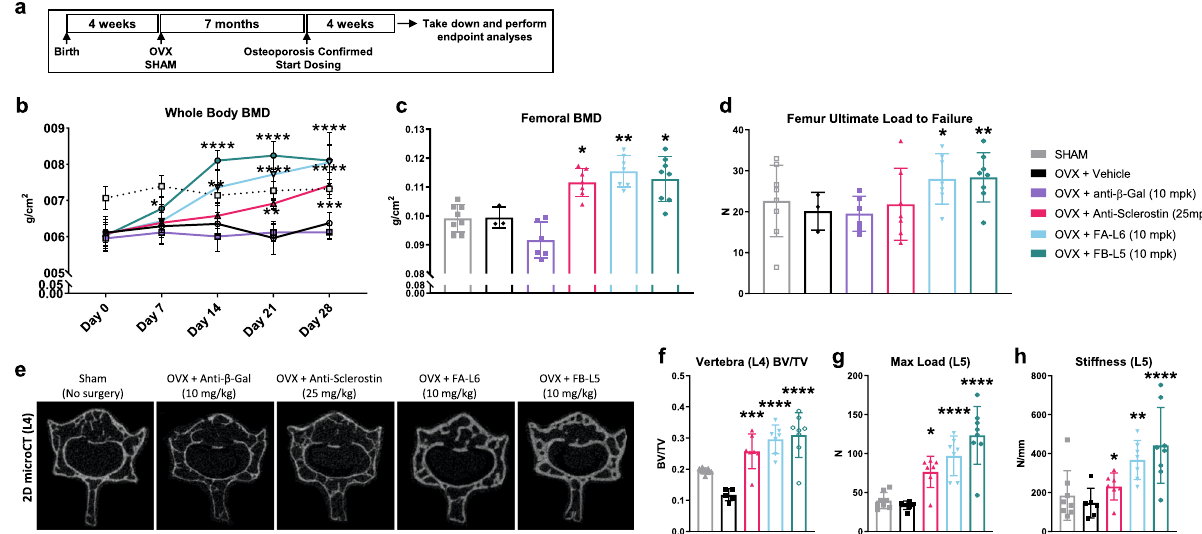
Fig. 6 Wnt mimetic antibodies reverse bone loss associated with ovariectomy induced osteoporosis. a Schematic of experimental design. 4-week-old C57BL6/J female mice were surgically ovariectomized (OVX). Seven months later, DEXA was used to con fi rm bone loss in the OVX groups prior to treatment initiation. Mice were injected bi-weekly with intraperitoneal administration of FA-L6 10 mg/kg or FB-L5 10 mg/kg antibody, or a negative (anti- β - gal) or positive control (bi-weekly subcutaneous injection of anti-sclerostin antibody 25 mg/kg) for 28 days. b Longitudinal DEXA measurements were collected and whole-body BMD quanti fi ed for days 0, 7, 14, 21, and 28 and c whole femur BMD on day 28. Bone strength at the mid-shaft femur was analyzed by a standard 3-point bending test and quanti fi ed for d average ultimate load to failure. e Representative micro-CT reconstructions of day 28 L4 lumbar vertebra (images from n = 8 samples/group having similar results) and f quanti fi cation of L4 BV/TV. Compressive loading was applied to L5 vertebrae to quantify g max load and h stiffness. Graphs represent mean values ± SD, n = 8 mice/group, except Vehicle + OVX, where n = 3. Statistical signi fi cance was determined by two-way ANOVA for b and one-way ANOVA for all others b – d and f – h , where the following letters de fi ne groups (a = OVX + Vehicle, b = OVX + Anti-Sclerostin, c = OVX + FA-L6, d = OVX + FB-L5) and * p < 0.05, ** p < 0.01, *** p < 0.001, **** p < 0.0001. b Day 7, a vs. d, p = 0.0135. Day 14, a vs. c, p = 0.0014, a vs. d, p ≤ 0.0001. Day 21, a vs. b, p = 0.0023, a vs. c, p ≤ 0.0001, a vs. d, p ≤ 0.0001. Day 28, a vs. b, p = 0.0005, a vs. c, p ≤ 0.0001, a vs. d, p ≤ 0.0001. c , a vs. b, p = 0.0427, a vs. c, p = 0.0023, a vs. d, p = 0.0156. d , a vs. c, p = 0.0164, a vs. d, p = 0.0098. f a vs. b, p